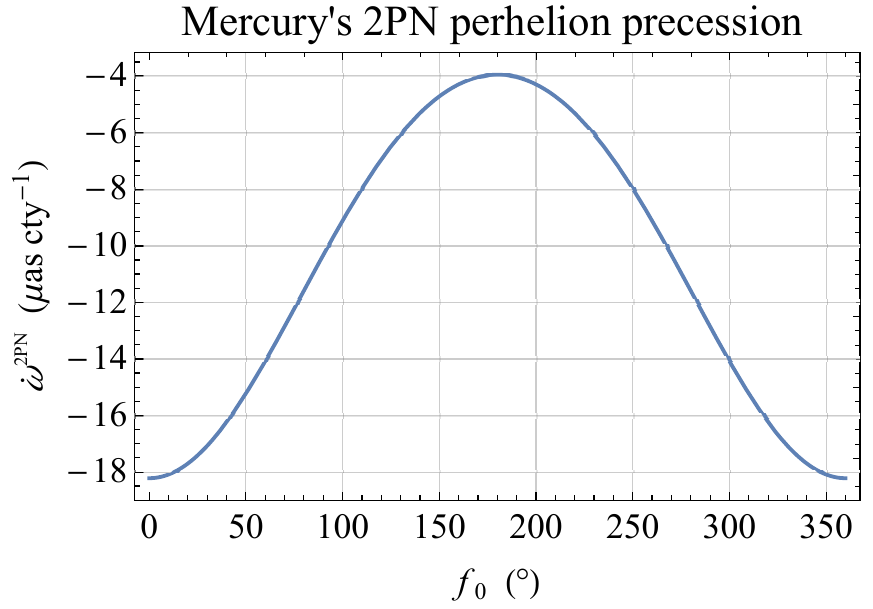
Figure 1. Total 2PN perihelion precession ˙ ω 2PN of Mercury, in µ ascty − 1 , as a function of the true anomaly at epoch f 0 according to Equation (1). It turns out that − 18 µ ascty − 1 (cid:46) ˙ ω 2PN (cid:46) − 4 µ ascty − 1